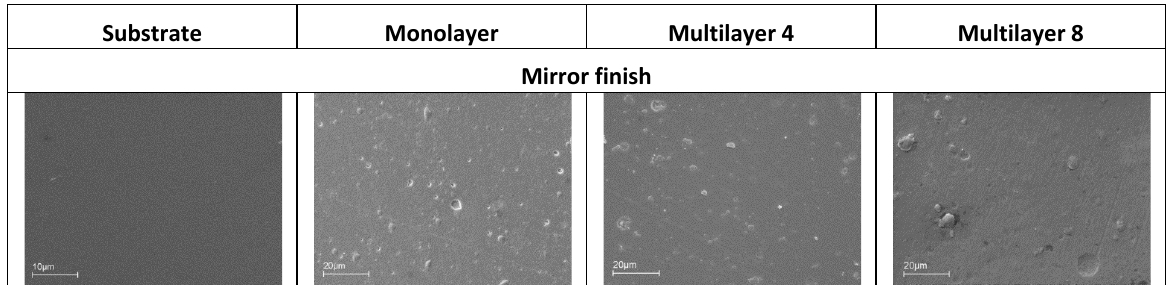
Figure 21. SEM images of X37CrMoV5-1 sample surfaces of different finished and coatings before and after